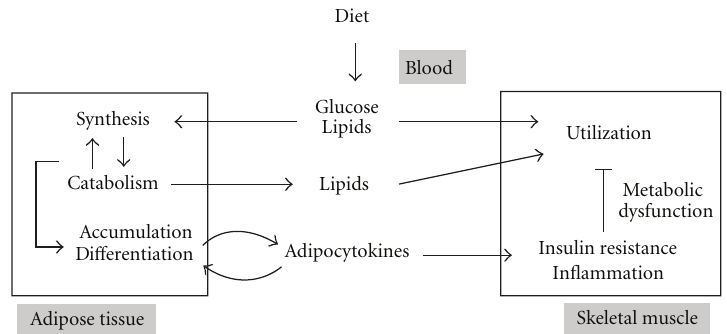
Figure 1: Crosstalk between skeletal muscle and adipose tissue in nutrient